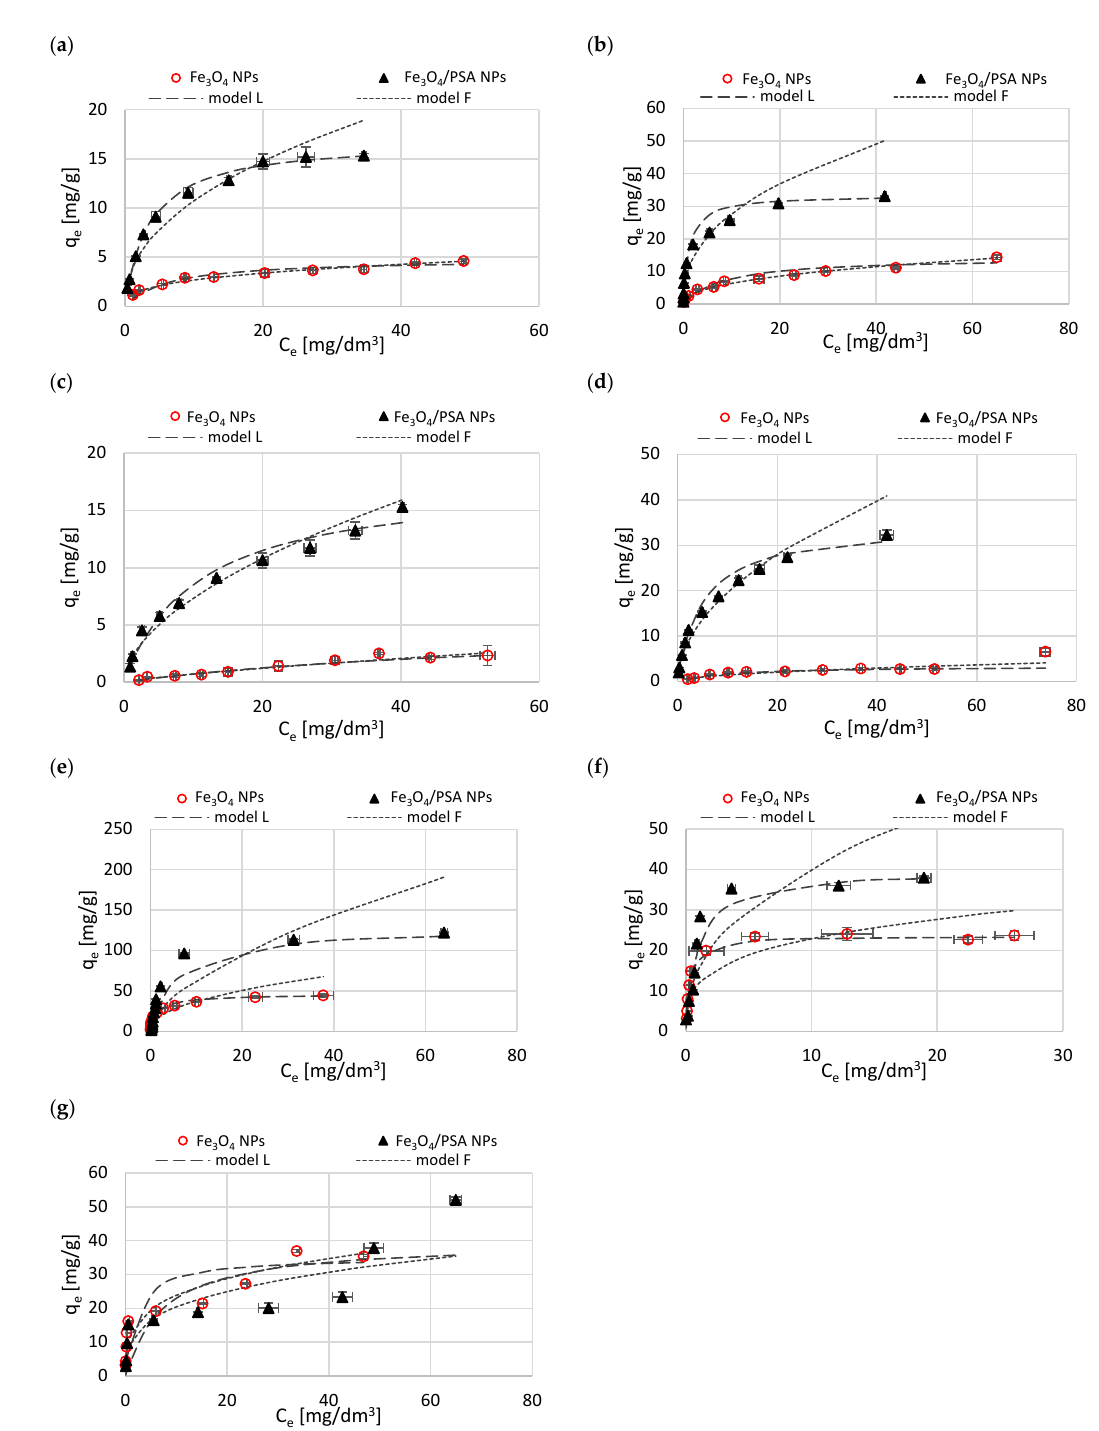
Figure 7. Isotherms of adsorption of Zn(II) ( a ), Cu(II) ( b ), Ni(II) ( c ), Cd(II) ( d ), Pb(II) ( e ), Cr(III) ( f ), Cr(VI) ( g ) on Fe 3 O 4 NPs and Fe 3 O 4 /PSA NPs at pH = 5.